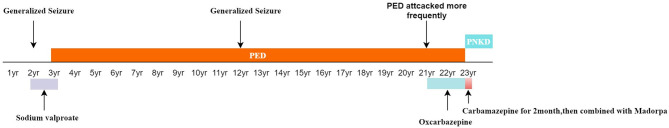
The timeline of the patient's symptom.